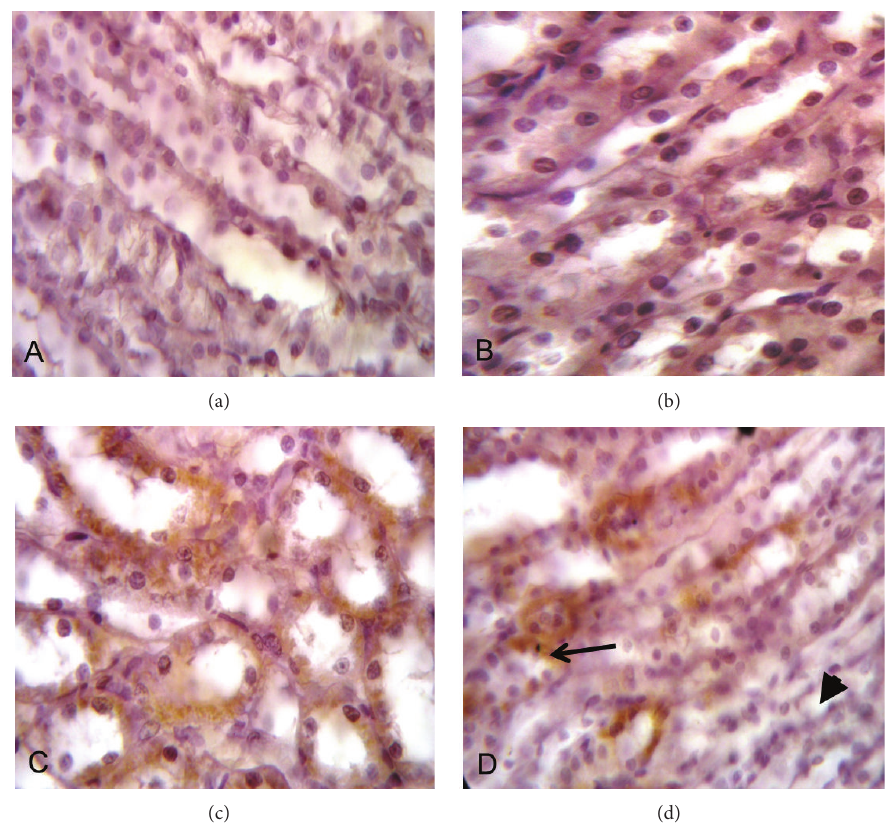
Figure 6: Effect of curcumin on localization of cyclooxygenase-2 (COX-2) immunoreactivity in rat renal medulla of methotrexate-induced nephrotoxicity in rats ( × 1000). ((a) and (b)) Sections from control and curcumin-treated groups show absence of COX-2 expression in the medullary tubules. (c) Methotrexate-treated group shows most of the medullary tubules exhibiting COX-2 staining. (d) Methotrexate plus curcumin treated group shows some medullary tubules displaying COX-2 expression (arrow) while others show absence of COX-2 expression